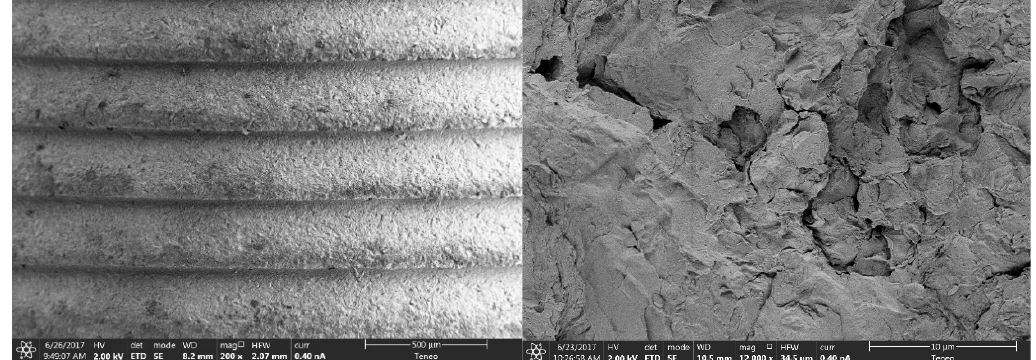
Figure 7. SEM images of the hydroxyapatite and tricalcium phosphate (HA/TCP) surface 200× ( left ) and 12,000× ( right ).